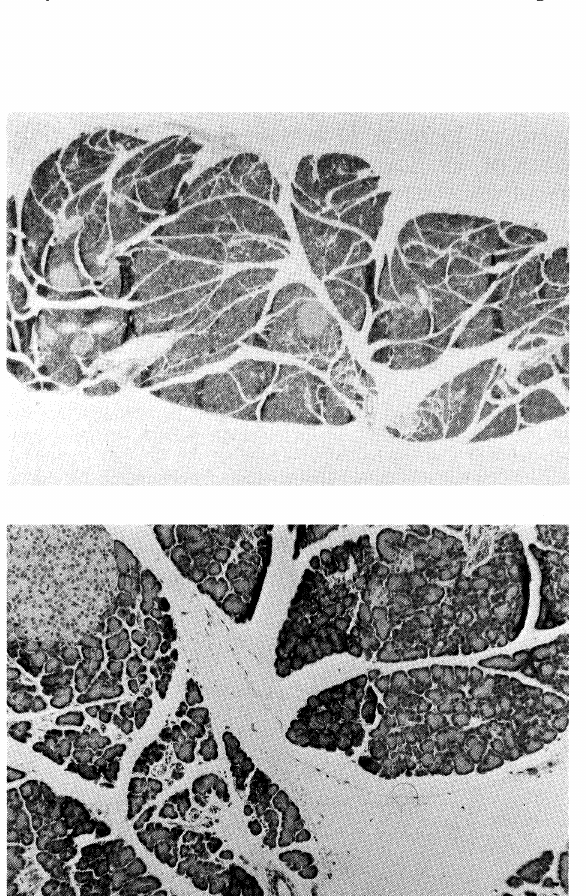
FIG. 1. Rat pancreas stained in haematoxylin-eosin after 6h of microdialysis (x 30 and x 125). Apart from slight interlobular ured oedema, the microscopic appearance of acini and Iobuli was